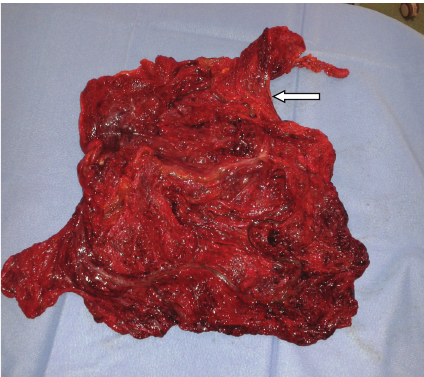
Figure 3: Twisted